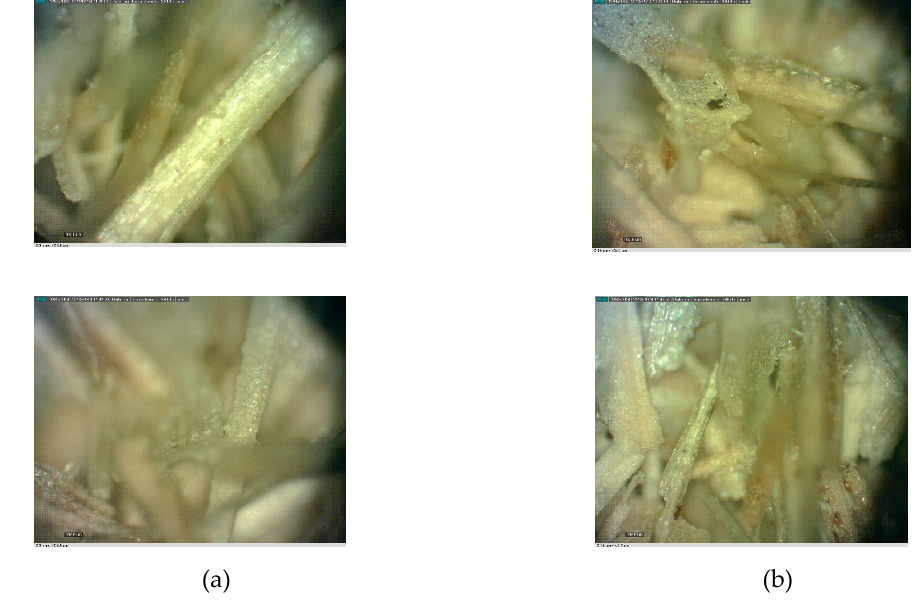
Figure 5. Fraction 0.3–0.85 mm ( a ) and 0.15–0.3 mm ( b ) of the straw powders at the magnification of 50× at optical microscope. 50 × at optical microscope.